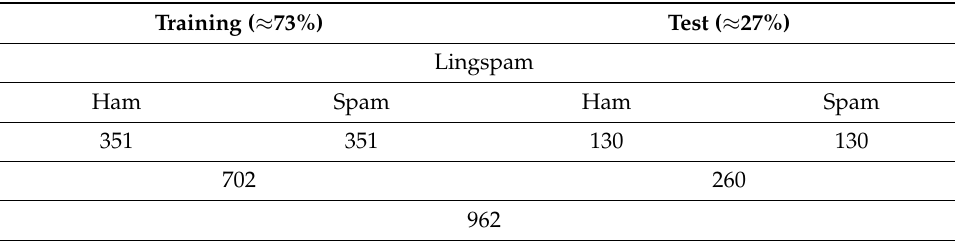
Table 7. Dataset 4 structure.